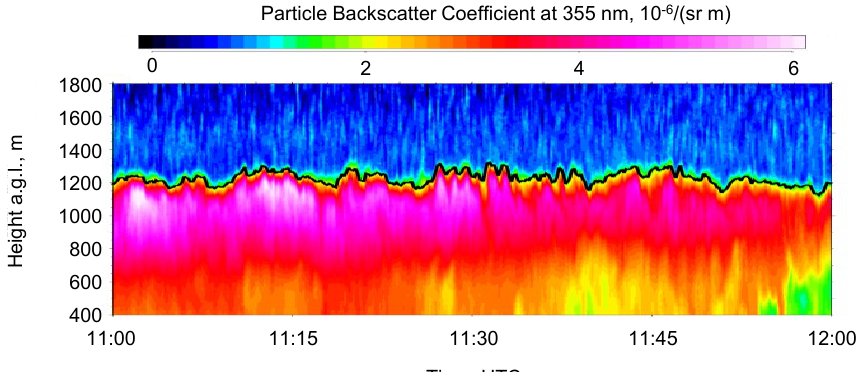
Figure 2. Time–height cross section of particle backscatter coefficient β par at 354.8nm measured with the UHOH RRL on 24 April 2013 between 11:00 and 12:00UTC. The temporal and spatial resolution of the data is (cid:49)t = 10s and (cid:49)z = 3 . 75m with a gliding average of 109m. The instantaneous CBL heights determined with the Haar-wavelet analysis of β par profiles are marked. a.g.l. (above ground level).